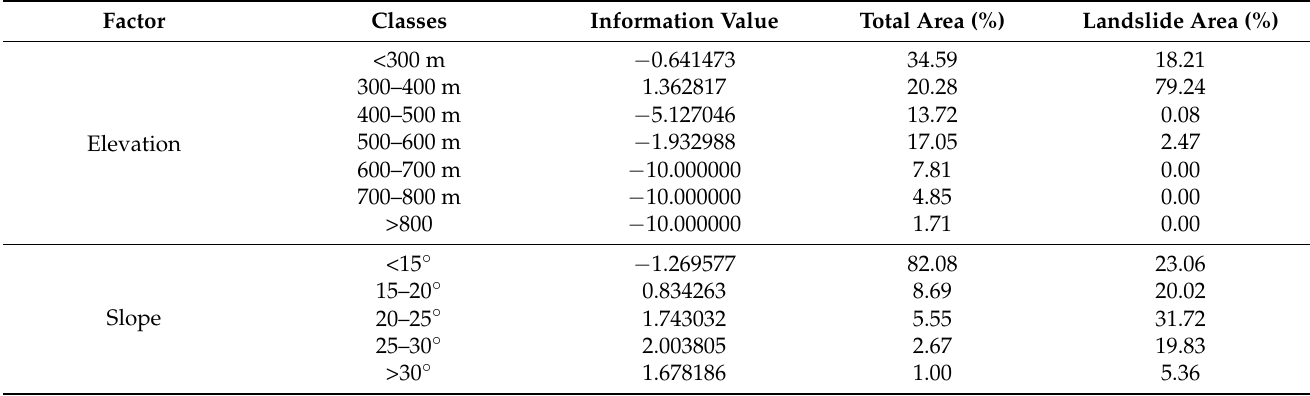
Table 4. Information values for susceptibility modeling; where a calculation of values was not possible (landslide area 0%), the values were set to − 10.